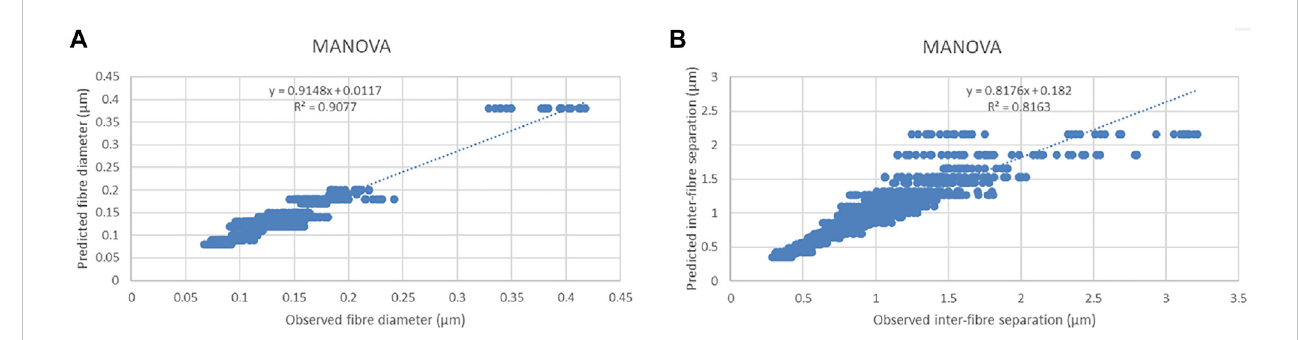
FIGURE 8 MANOVA predictions for (A) diameter of the fi bres and (B) inter- fi bre separation.